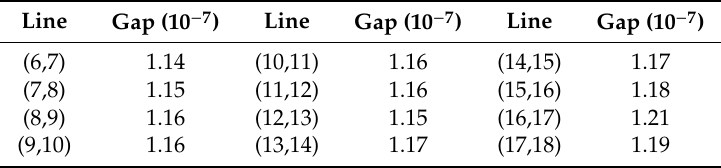
Table 8. Relaxation Gap for Certain Distribution Lines in Case